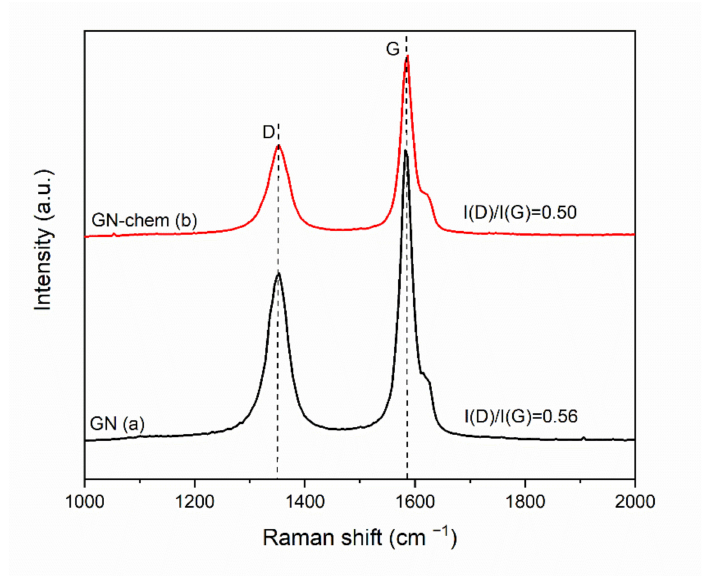
Figure 1. Raman spectra of ( a ) pristine graphene nanosheets (GN) and ( b ) chemically modified graphene nanosheets